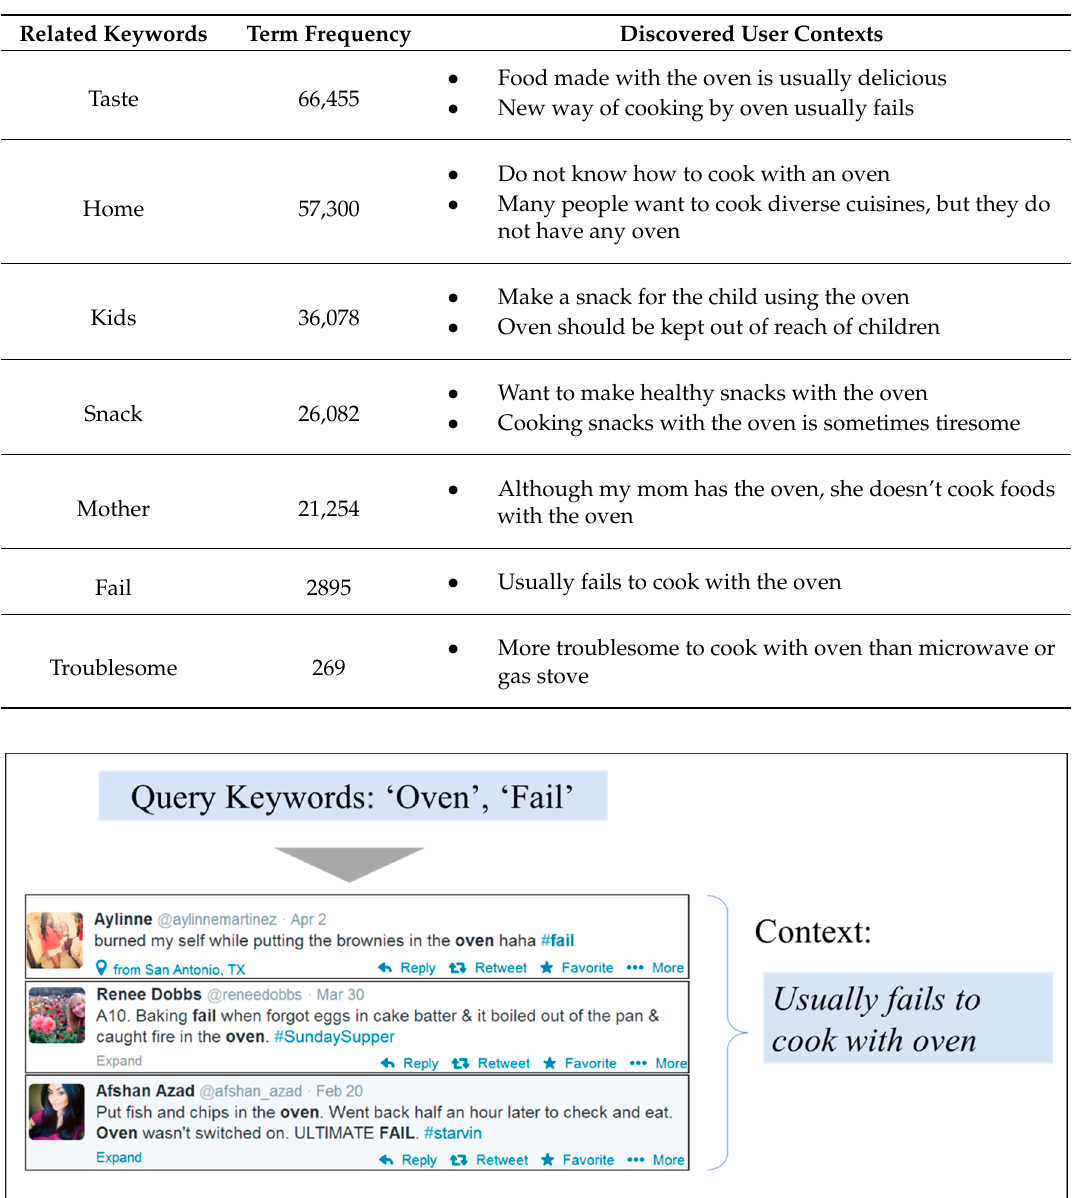
Table 4. Keywords related to ‘oven’ and corresponding user contexts.